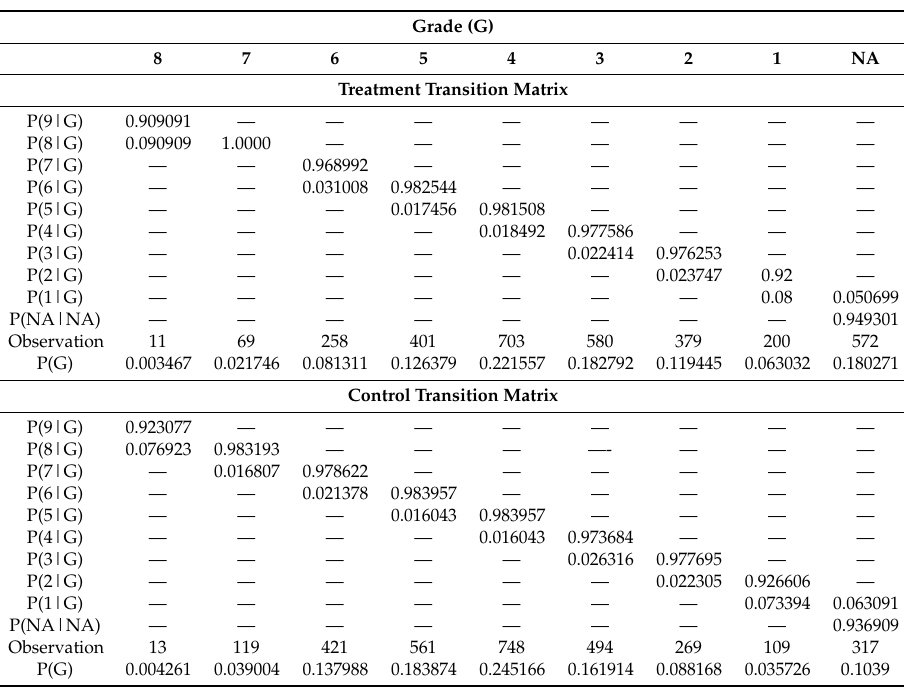
Table A5. Transition matrices (ages